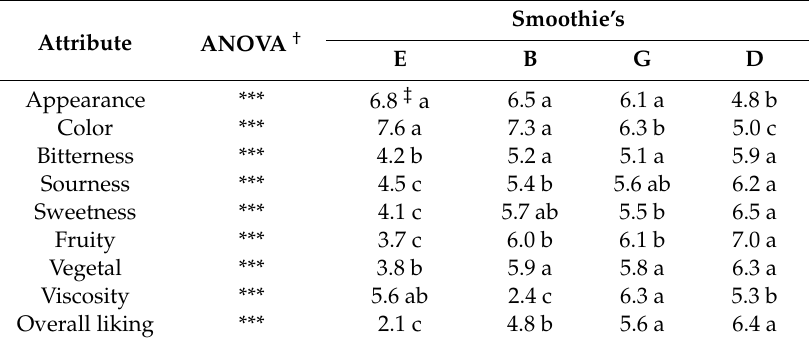
Table 5. Mean scores and ANOVA for liking degree of a Spanish group of Millennial consumers for color, appearance, flavor notes (fruity, vegetal), basic tastes (sweetness, sourness), viscosity and overall liking of selected commercial